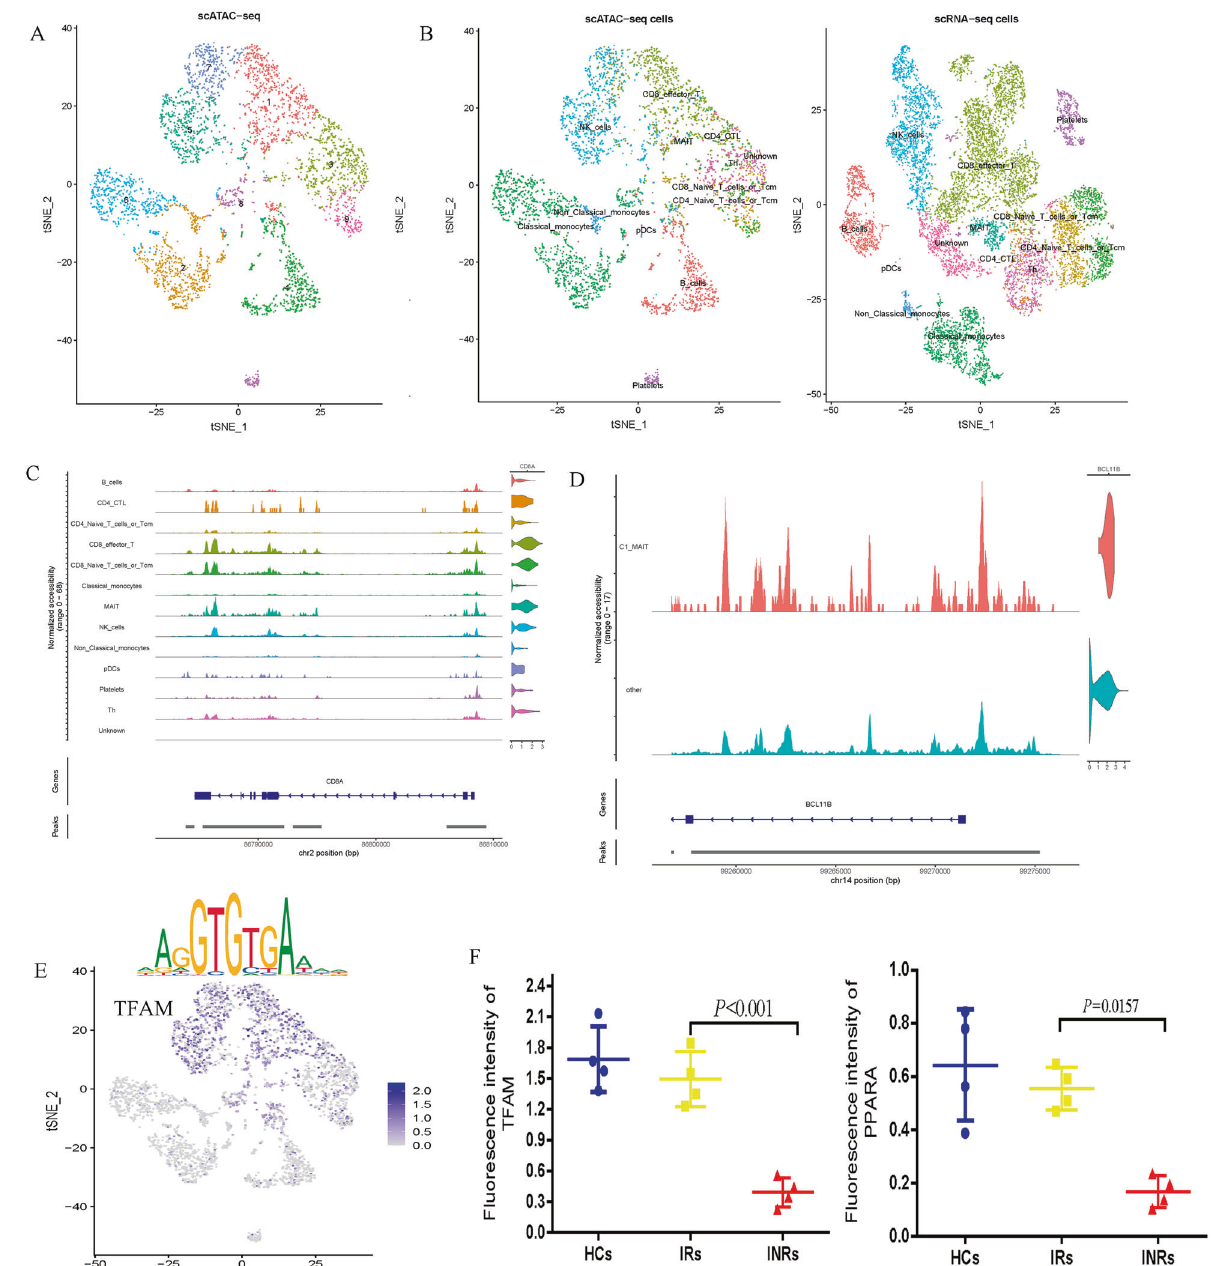
Fig. 4 scATAC-Seq reveals open chromatin landscapes of single cells in INR. A tSNE plots showing single-cell open chromatin pro fi les analyzed in the study, color-coded for cell clusters. B Display after integration of scATAC-Seq and scRNA-seq. C scATAC-seq tracks showing open chromatin peaks associated with cell-type-speci fi c genes across different cell clusters. D Chromatin open state of BCL11B gene in MAIT cells derived from INR. E Transcription factor motif enrichment (upper) and gene expression pro fi les (bottom row) for TFAM. F Mean fl uorescence intensity of TFAM and PPARA expression in MAIT cells from HCs, IRs and inhibition [32]. Many factors are related to the failure of immune reconstitution in HIV/AIDS patients. Over the years, several retrospective studies have been conducted on patients with poor immune reconstitution. Overwhelming evidence substantiates that age, baseline CD4 + T lymphocyte level, HCV co-infection and other factors can affect the immune reconstitution of patients [33 – 36]. However, the mechanism underlying immune reconstitu- tion failure is poorly understood. Single-cell sequencing technol- ogy is a new technology for high-throughput sequencing analysis of genome, transcriptome and epigenome at the single-cell level.